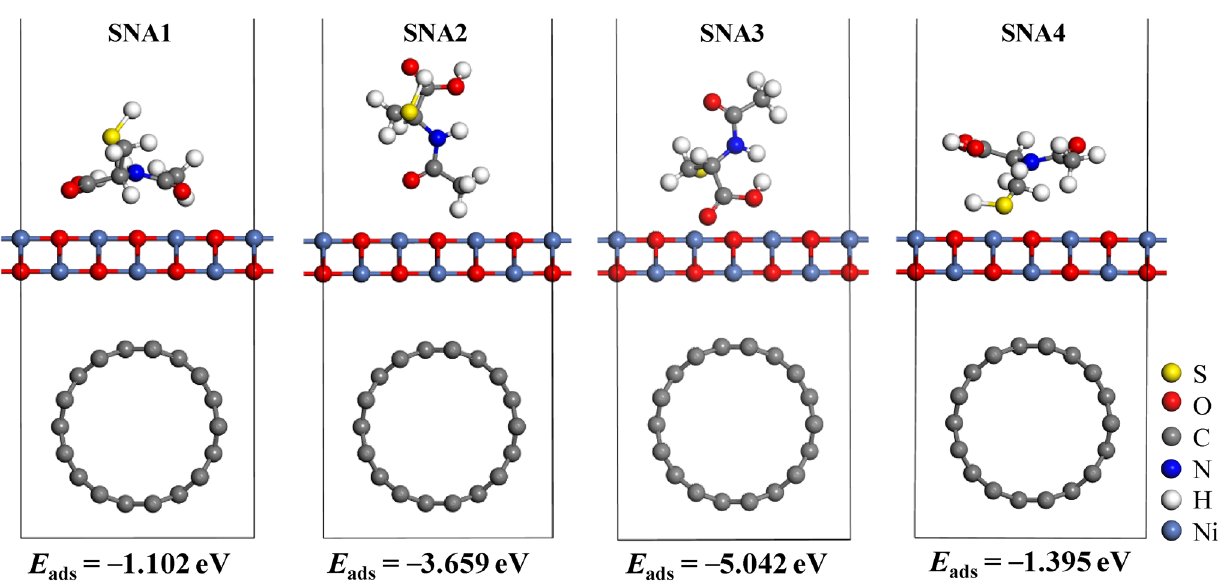
Figure 9. Various relaxed adsorption configurations of N- acetylcysteine onto NiO–SWCNTs